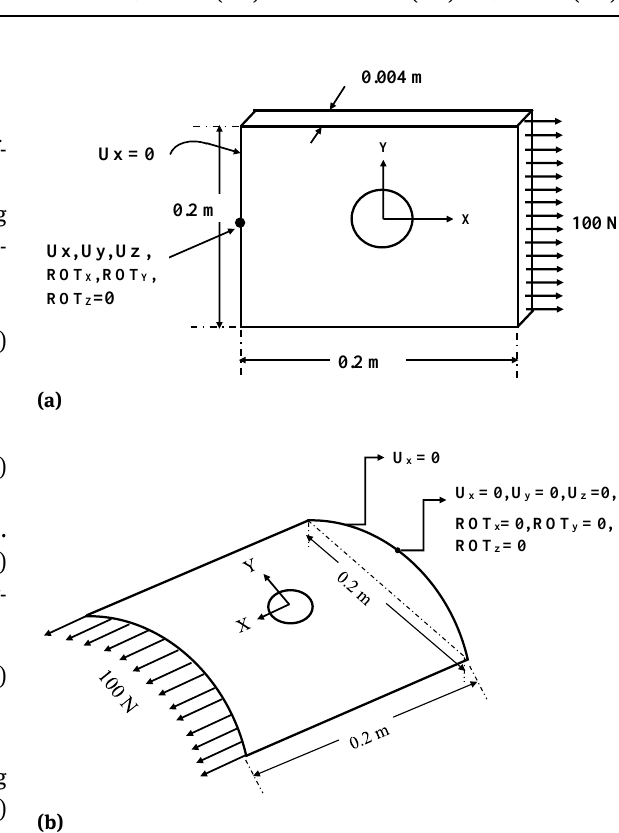
Figure 3: Finite element model of (a) flat and (b) singly curved com- posite plates with